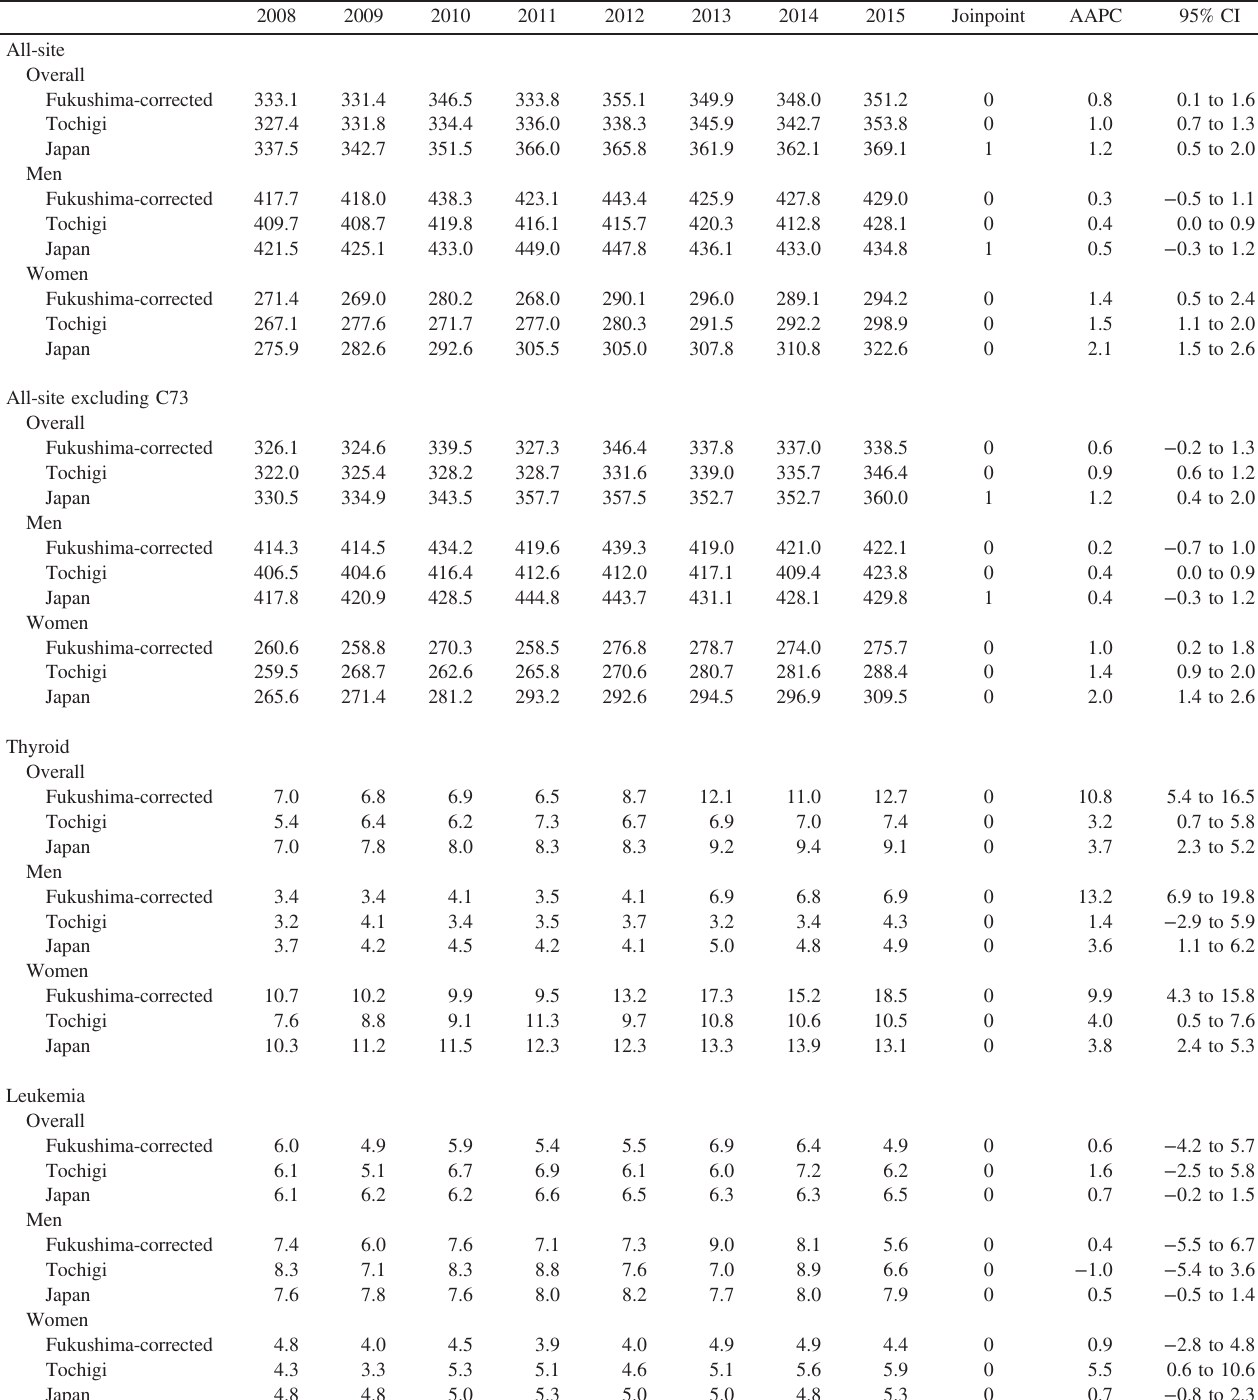
Table 2. Age-standardized annual incidence between 2008 and 2015 by sex and cancer type (per 100,000 population, 1985 Japanese population model), AAPC, and 95%